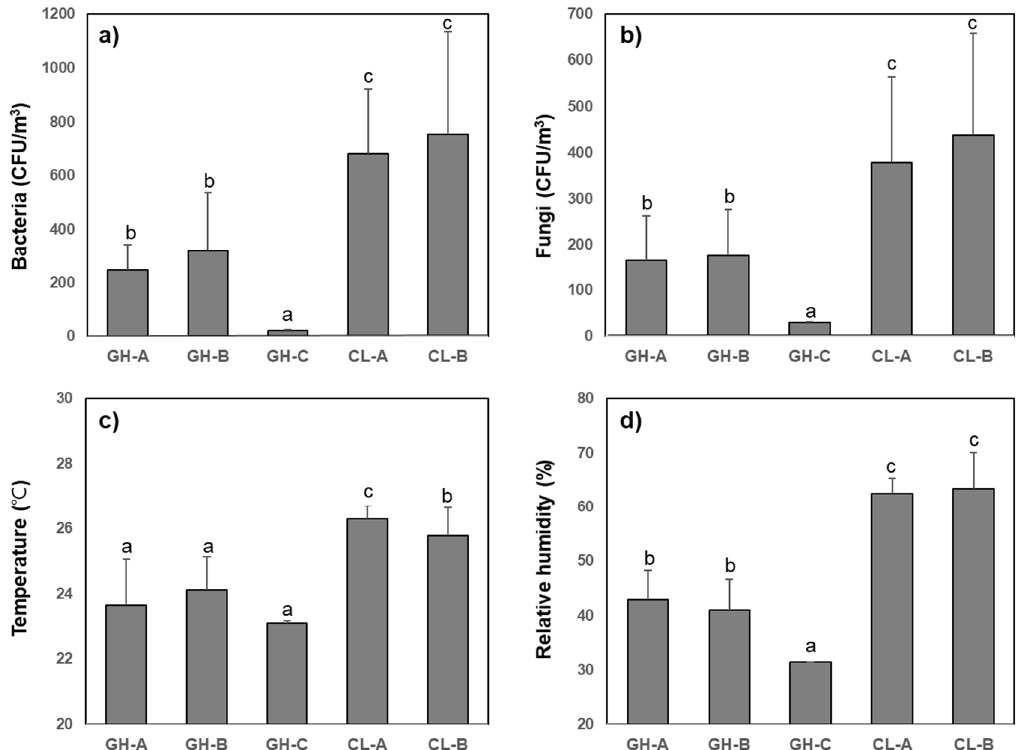
Figure 1. Distribution of airborne bacteria ( a ) and fungi ( b ), and meteorological conditions ( c,d ) in general hospitals (GH-A, GH-B, and GH-C) and clinics (CL-A and CL-B). a,b,c same letters indicate no significant difference based on Duncan’s multiple comparisons ( p < 0.001).